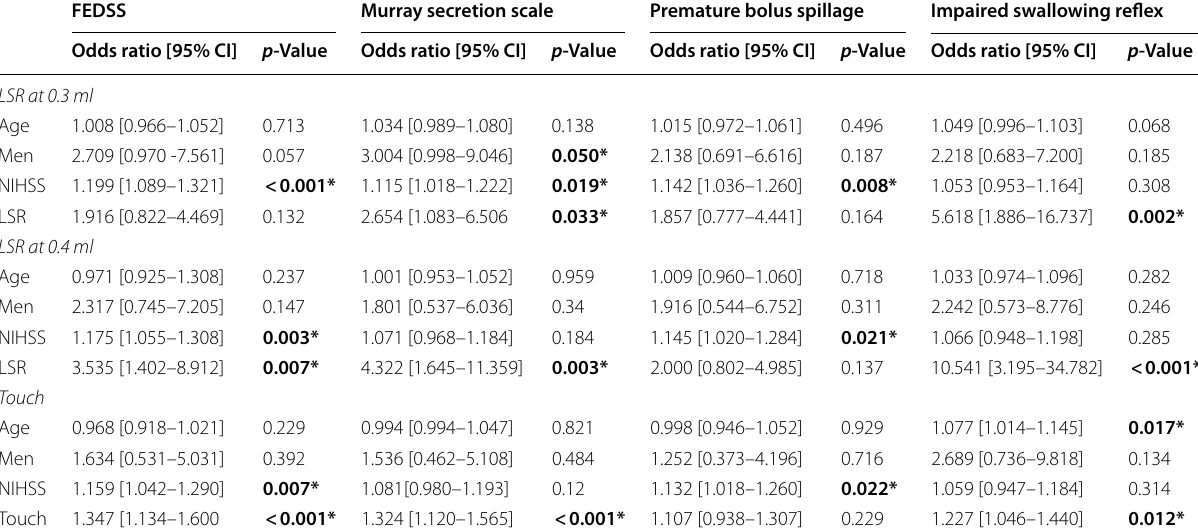
FEDSS Fiberoptic Endoscopic Dysphagia Severity Scale; CI Confidence interval; NIHSS National Institute of Health Stroke Scale; LSR Latency of Swallowing Response; * and bold printing indicate statistically significant p -values